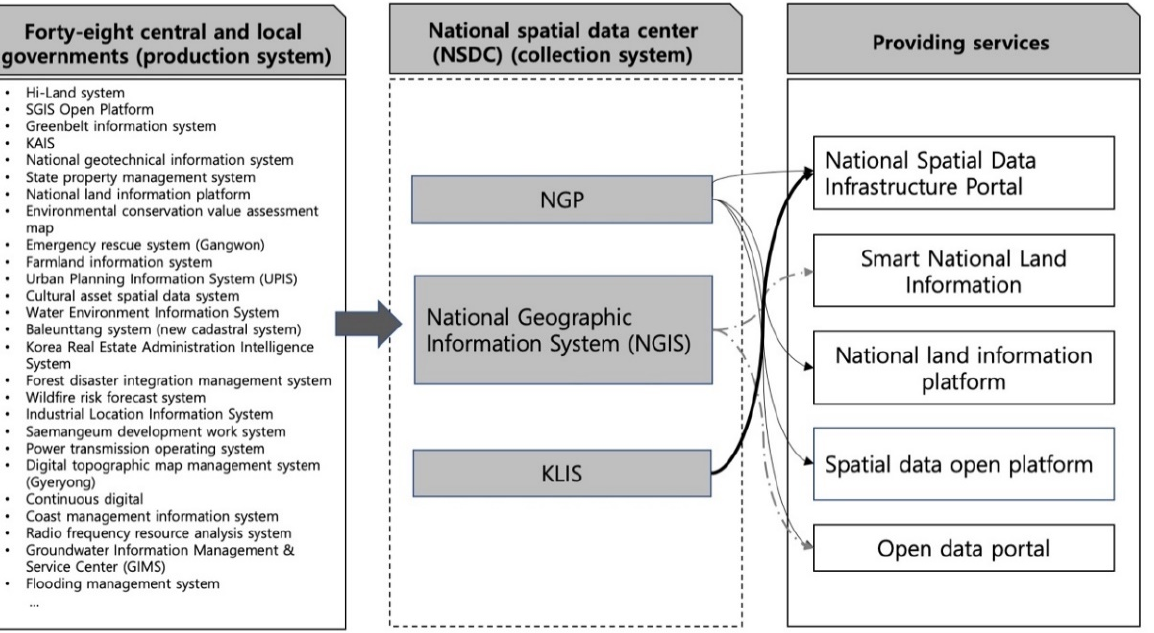
Figure 1. Three-layer system of spatial data: production, collection (distribution), and service. Spatial data are developed through a system that manages national land, seas, cities, environment, and disasters. There are two available systems: one manages specific topic data through the combination of spatial and attribute data, and the other develops and manages spatial data, such as continuous digital maps, digital topographic maps, control points, and images (Table